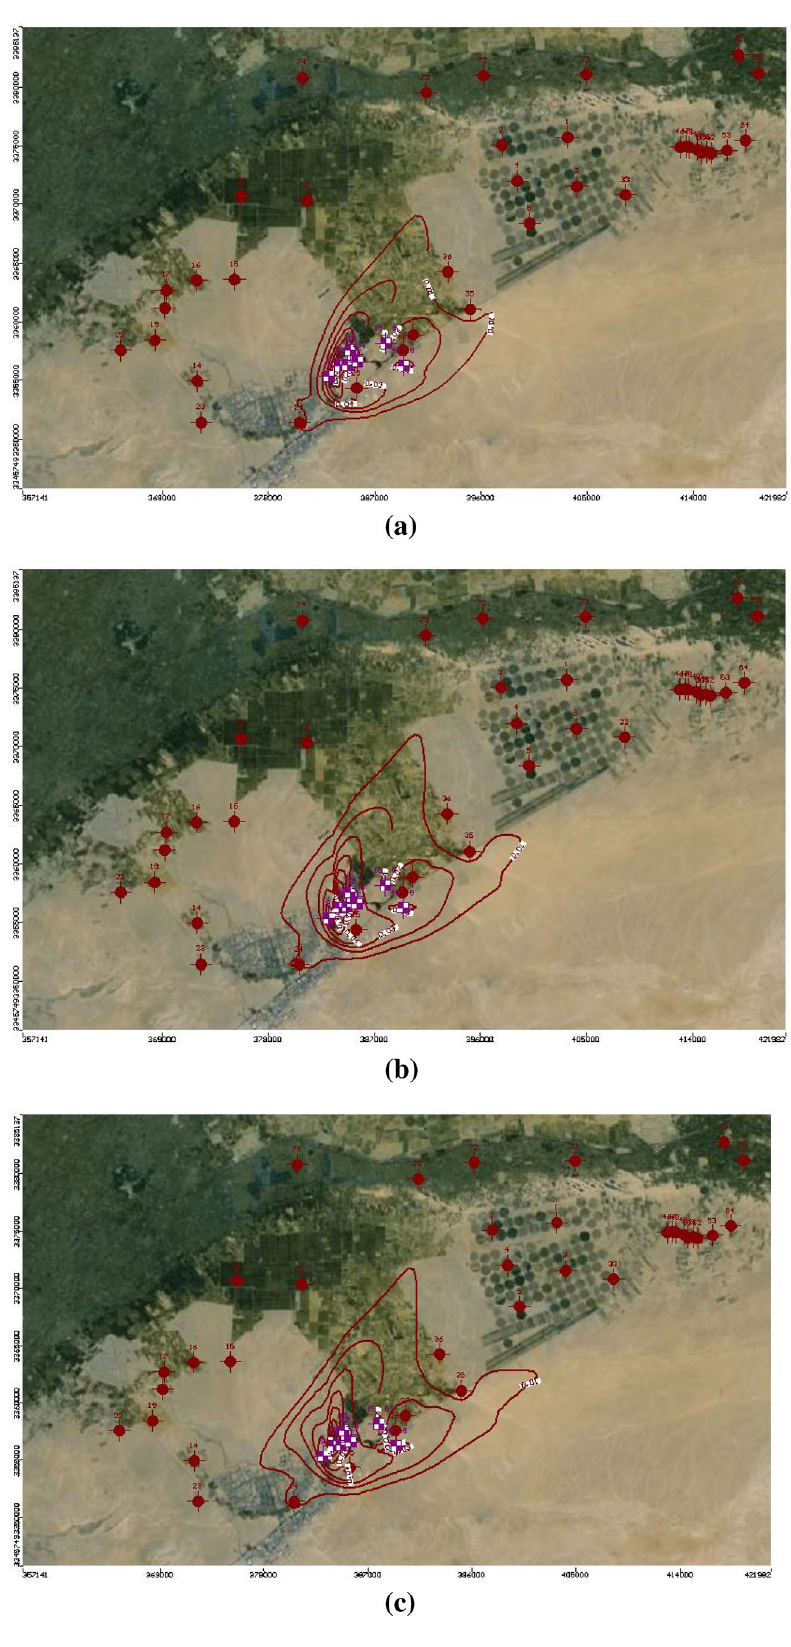
Fig. 13 Sr pollutant transport a after 10 years, b after 20 years, and c after 30